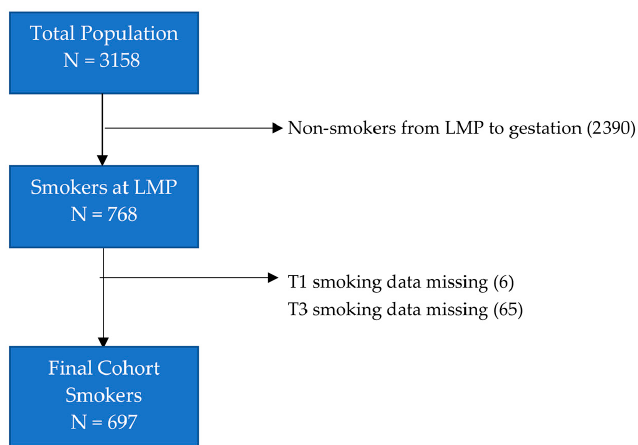
Figure 1. Flow diagram for study participants. Abbreviations: LMP last menstrual period; T1 first trimester; T3 third trimester.